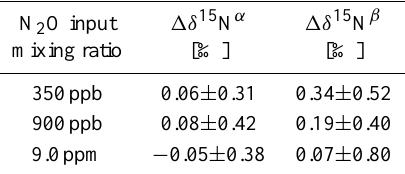
Table 3. Changes in the N 2 O δ values ( 1δ 15 N= δ 15 N precon – δ 15 N original ) after dilution and preconcentration compared to the unprocessed calibration gas ( n =3–5). Error bars represent the ex- panded uncertainty (95% confidence